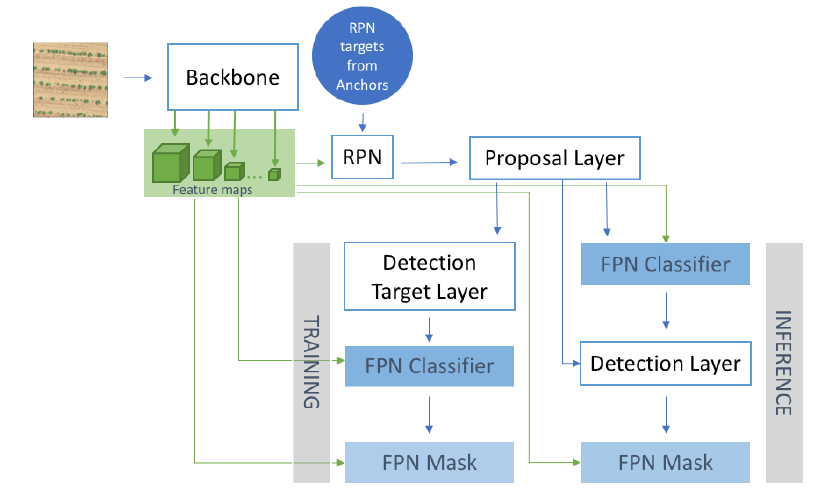
Figure 3. Mask R-CNN